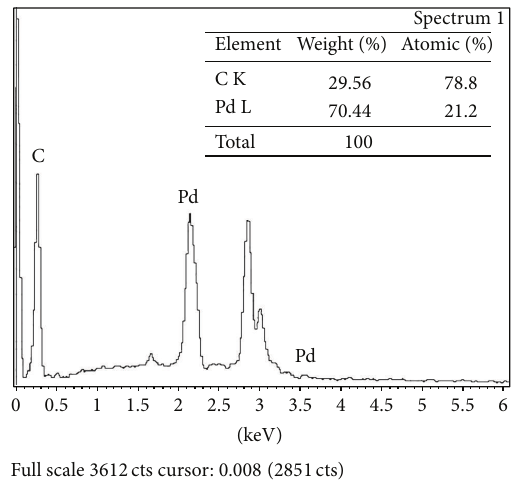
Figure 3: EDX analysis of XL-QPPd